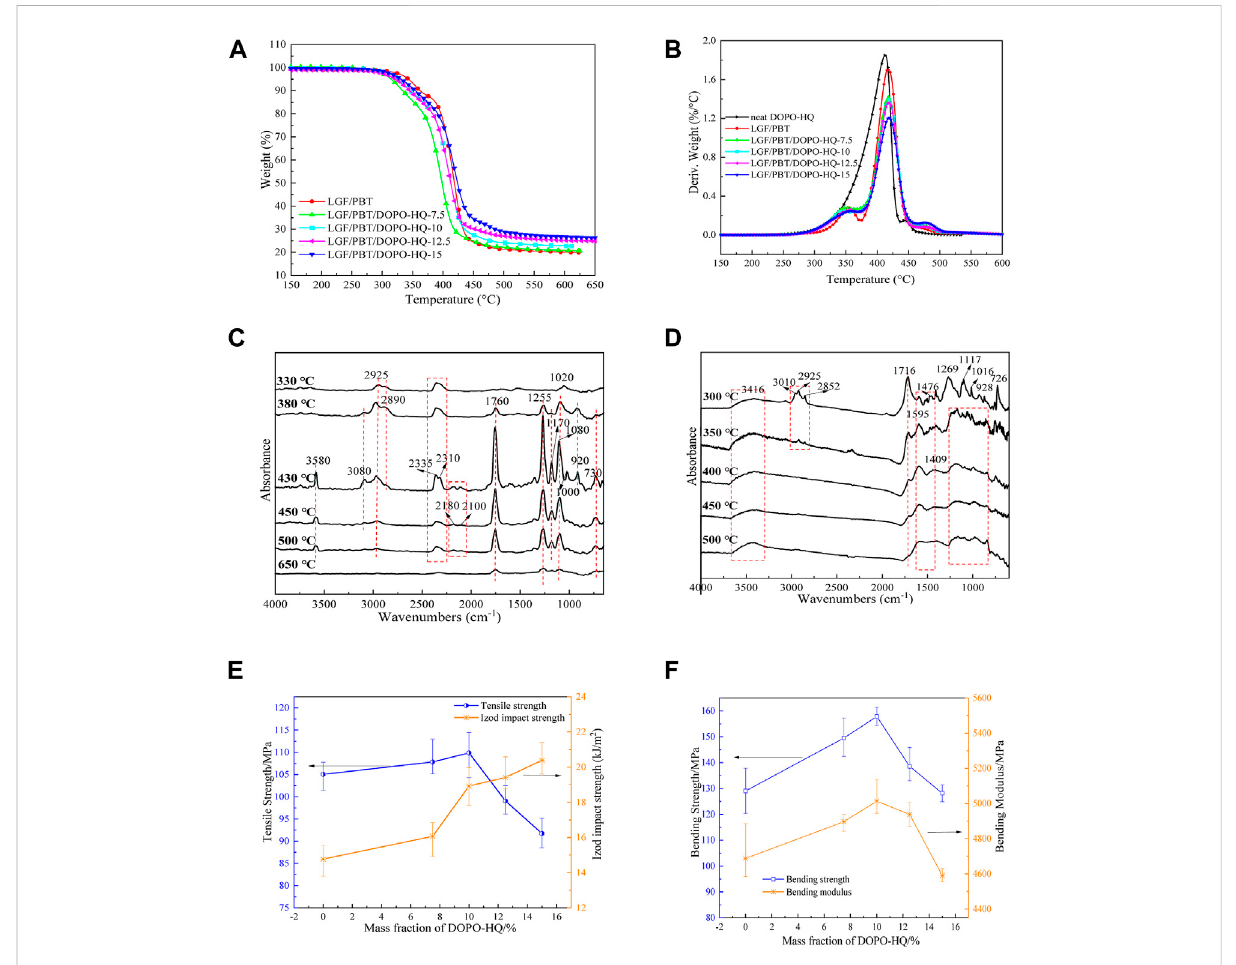
FIGURE 2 (A,B) : TG and DTG curves of LGF/PBT/DOPO-HQ-conjugated fl ame-retardant composites at the heating rate of 10 ° C/min in N 2 . (C) LGF/PBT/ DOPO-HQ-conjugated fl ame-retardant composites and FTIR spectra of materials in the condensed phase, (D) the TG-FTIR results of LGF/PBT/ DOPO-HQ-conjugated fl ame-retardant composites. (E) The tensile strength and Izod impact strength (F) the bending strength and bending